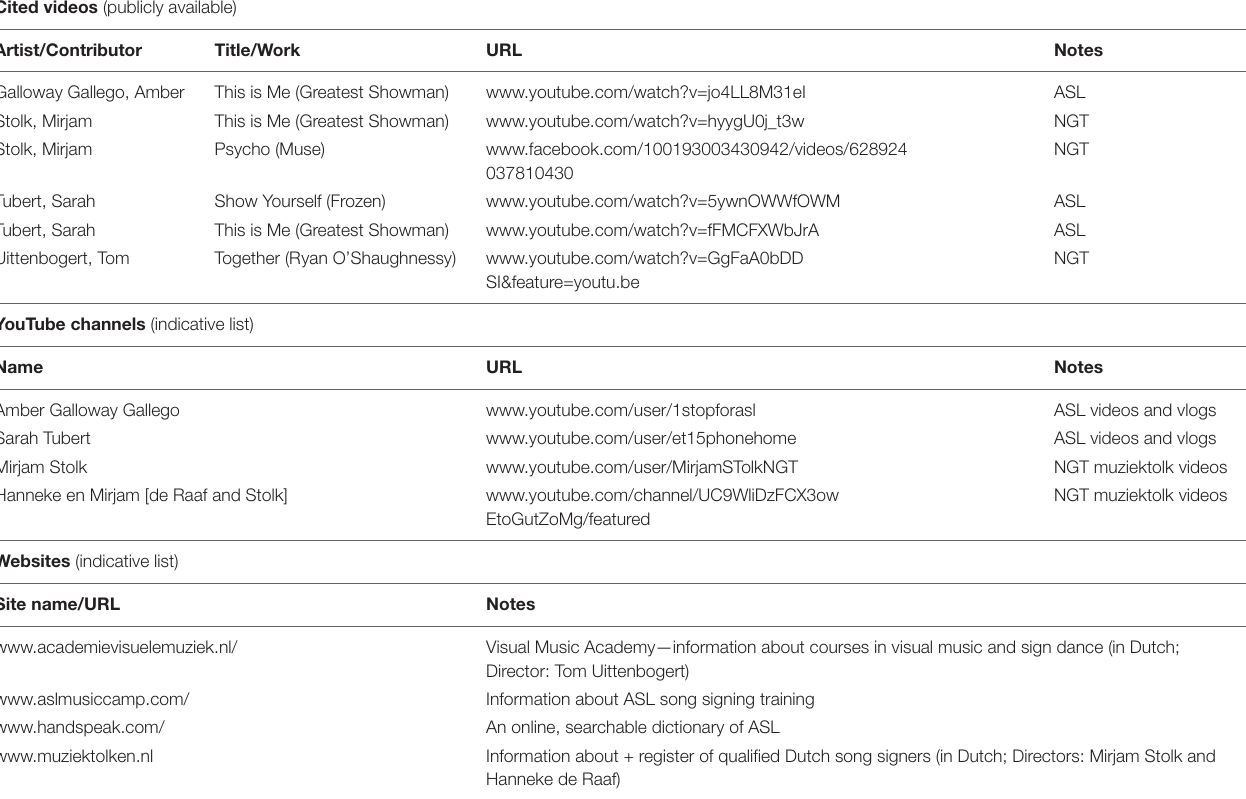
TABLE 1 | List of web resources including cited